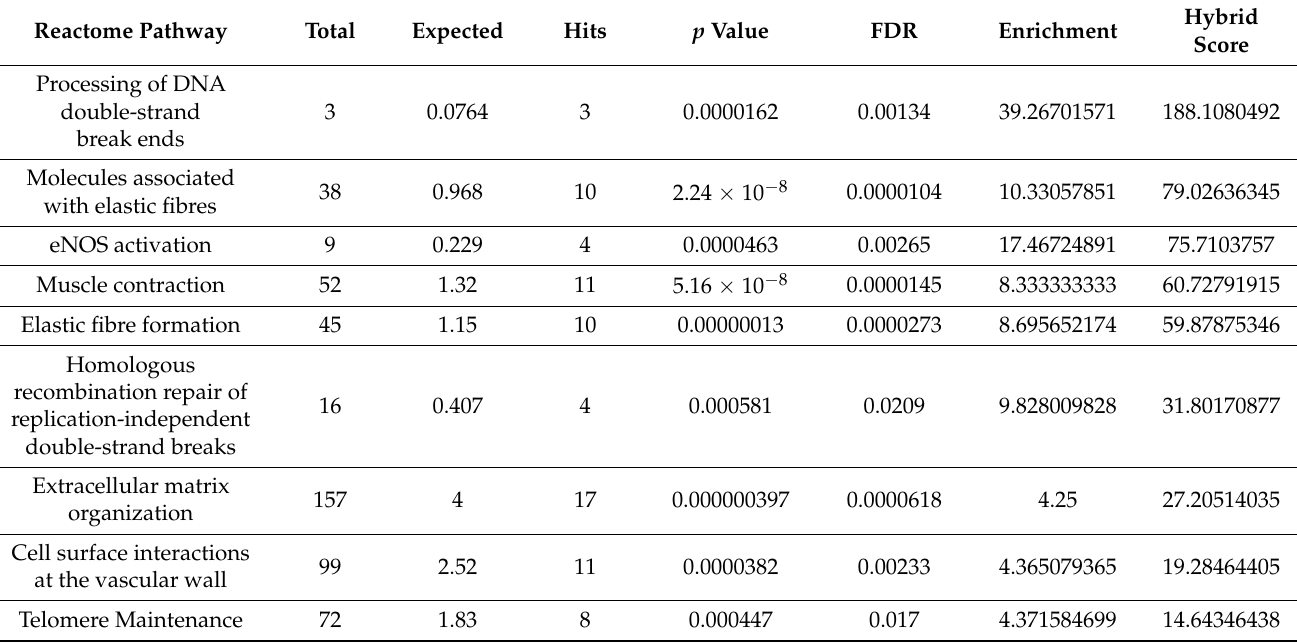
Table 2. Reactome pathway analysis performed upon a Zero-order human PPI network generated with the differentially expressed warfarin response data sets. False Discovery rate (FDR), enrichment ratio (Enrichment), negative log10 of enrichment probability multiplied by the enrichment ratio (Hybrid